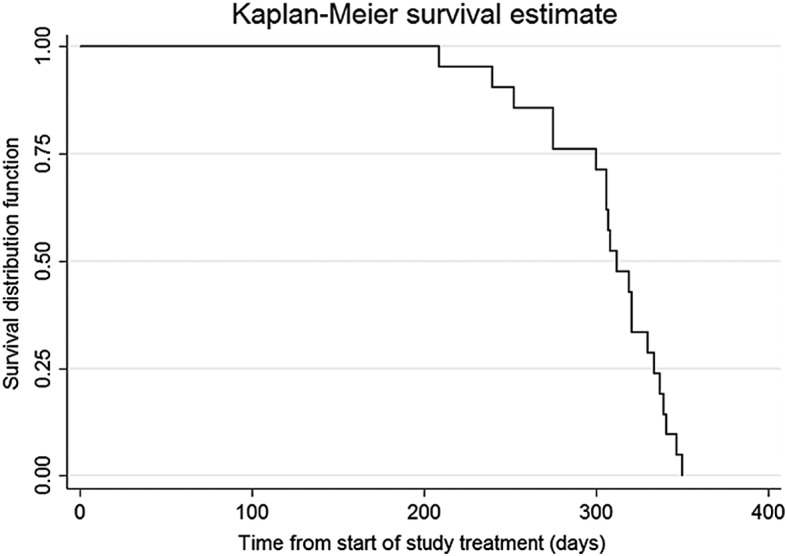
Kaplan-Meier estimate of the median overall survival was 10.4 months (95% confidence interval, 10–11 months).